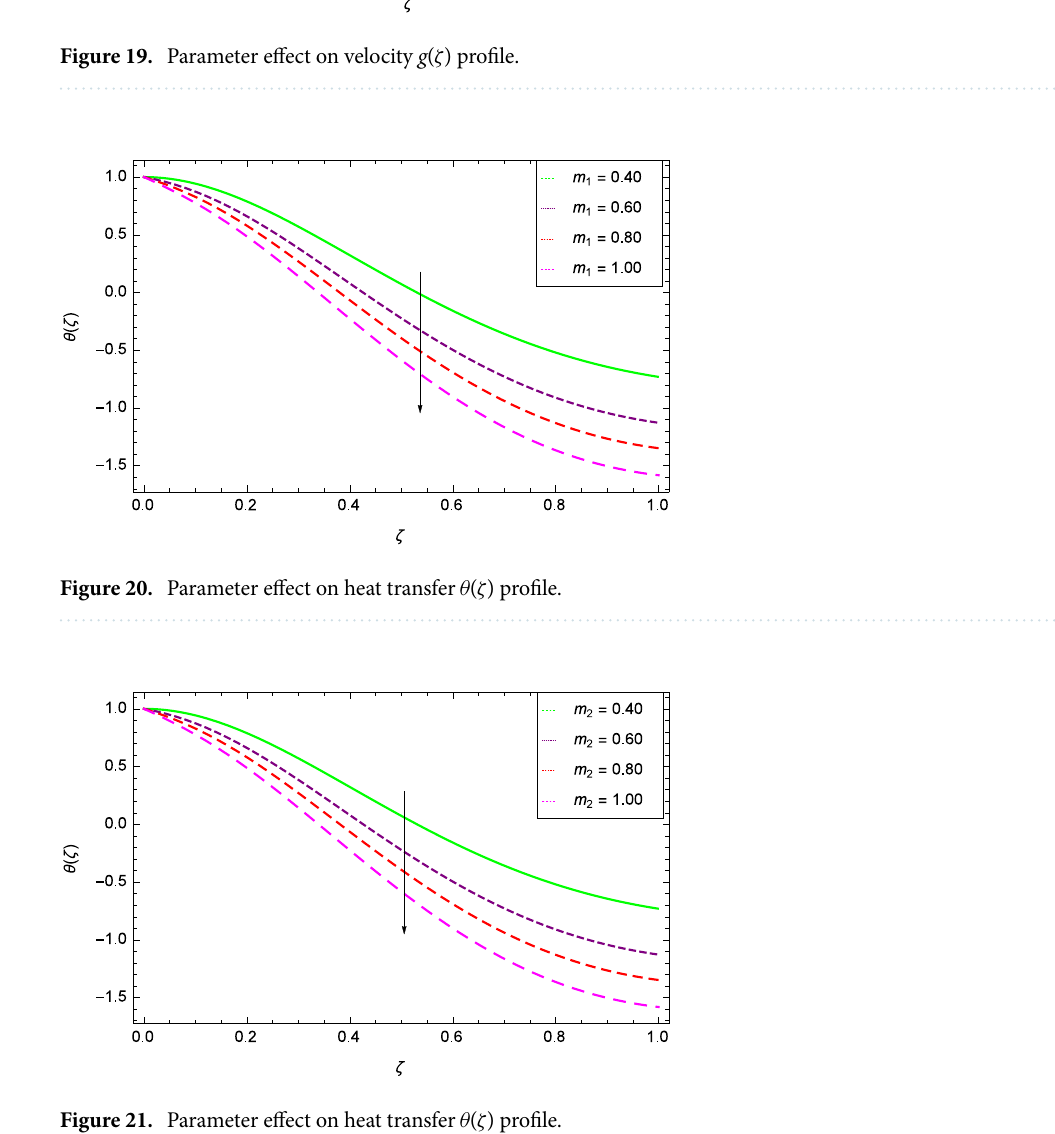
Figure 21. Parameter effect on heat transfer θ ( ζ )